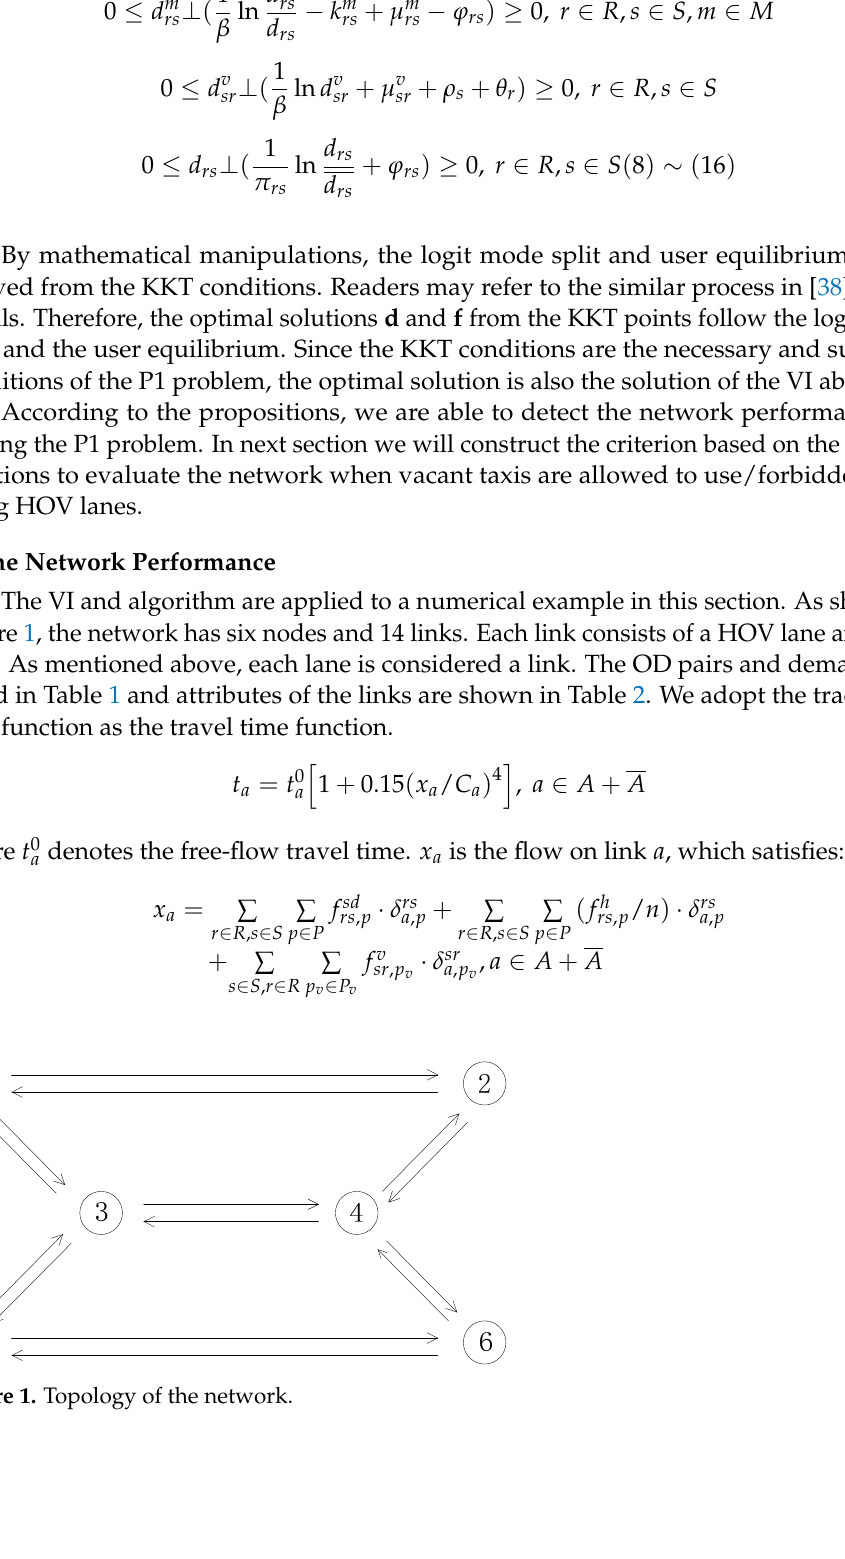
0 Table 2. Free-flow travel time, capacity, and length of lanes. Link